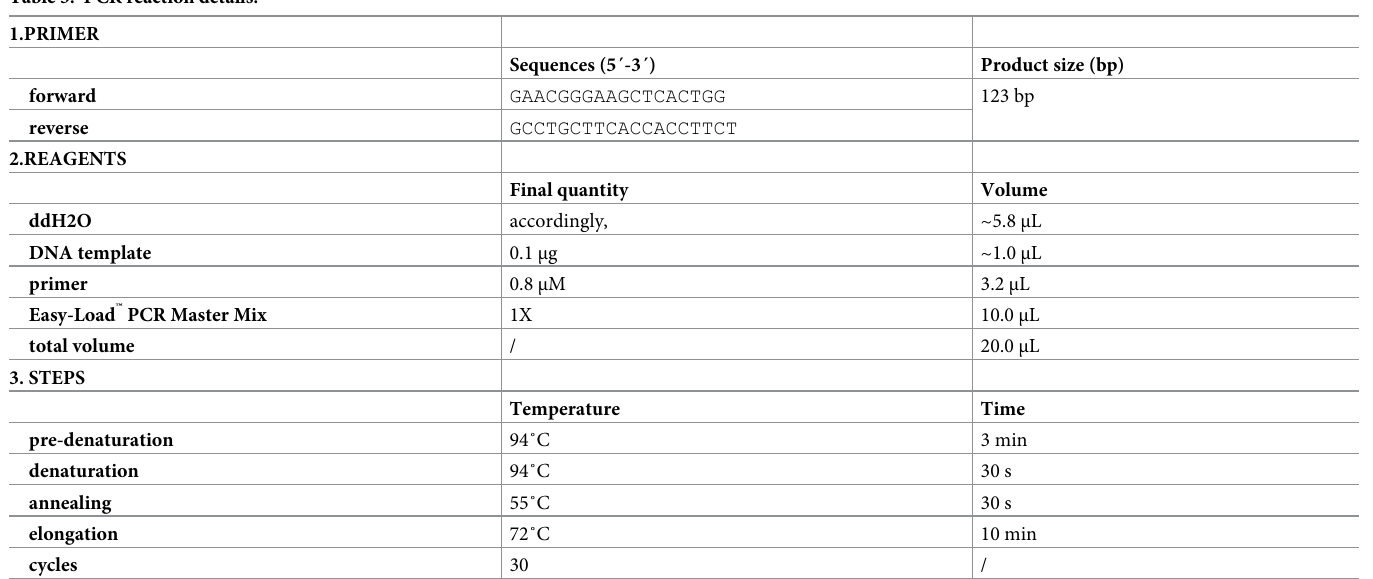
Table 3. PCR reaction details.